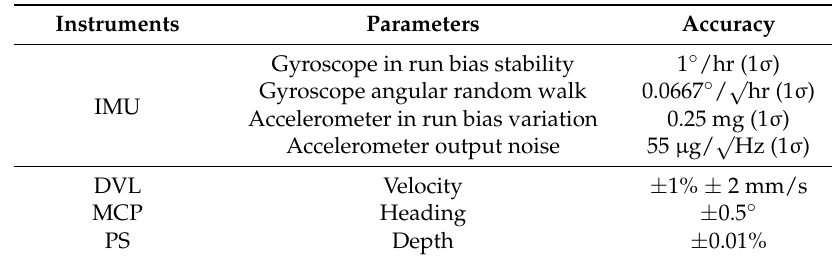
Table 1. Instrument specifications.